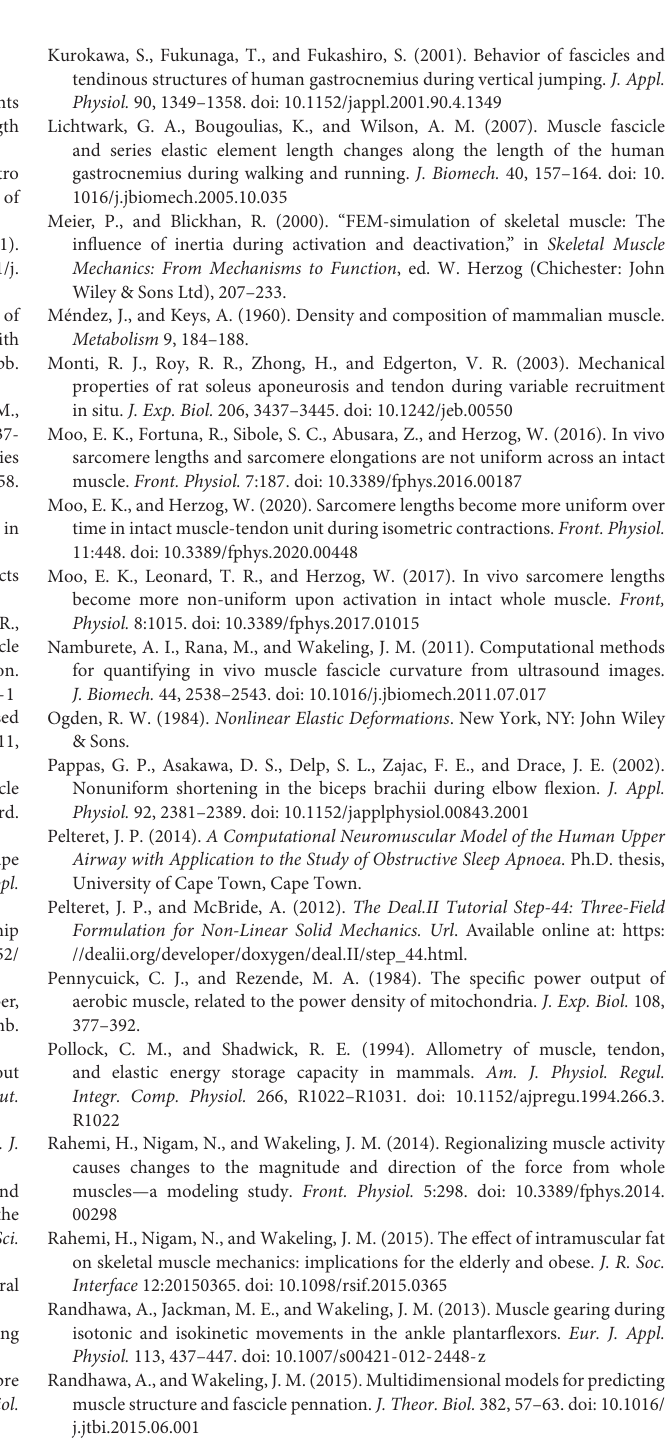
velocity in the current configuration at points that were in the xz plane at y = 0 in the initial configuration at times t = 0.125 s when the muscle was at its longest length, t = 0.25 s halfway through the shortening phase, t = 0.375 s when the muscle was at its shortest length, and t = 0.5 s when the muscle was at its initial